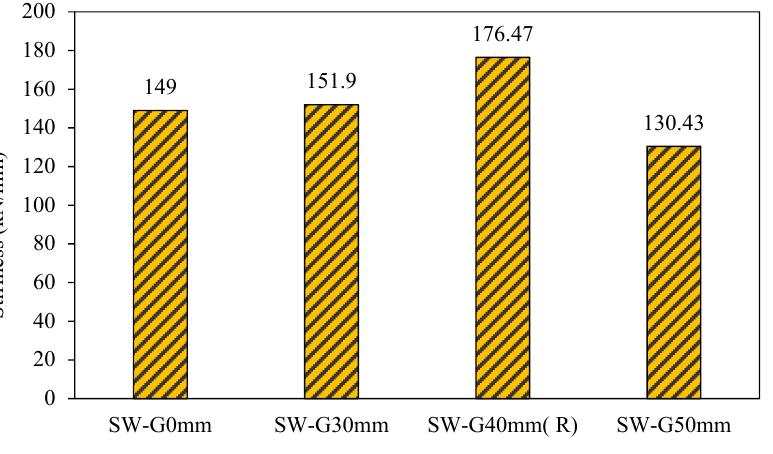
Figure 11. Stiffness of group 1.